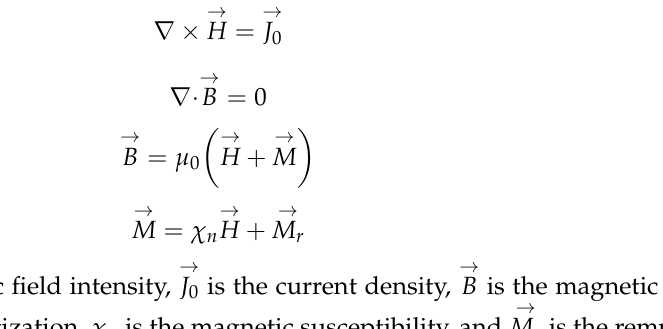
Figure 6. BLDC noise simulation setup. 3. Results 3.1. Numerical Analysis and Verification Acoustic simulation and measurements were performed to analyze the noise gener- ated by the geometry of the BLDC motor. To verify the simulation model, a prototype BLDC motor was fabricated, and the motor noise was measured in an anechoic environ- ment as shown in Figure 7a. The BLDC motor noise measurement equipment consisted of a B&K 4165 microphone, B&K microphone multiplexer microphone amplifier, and LMS analysis equipment, as displayed in Figure 7b. To compare the experiment to the analysis under the same conditions, the noise was measured at an applied voltage of 13.5 V and a rotational speed of 1000 rpm. The measurement and simulation results in the noise of BLDC motor are shown in Figure 8.